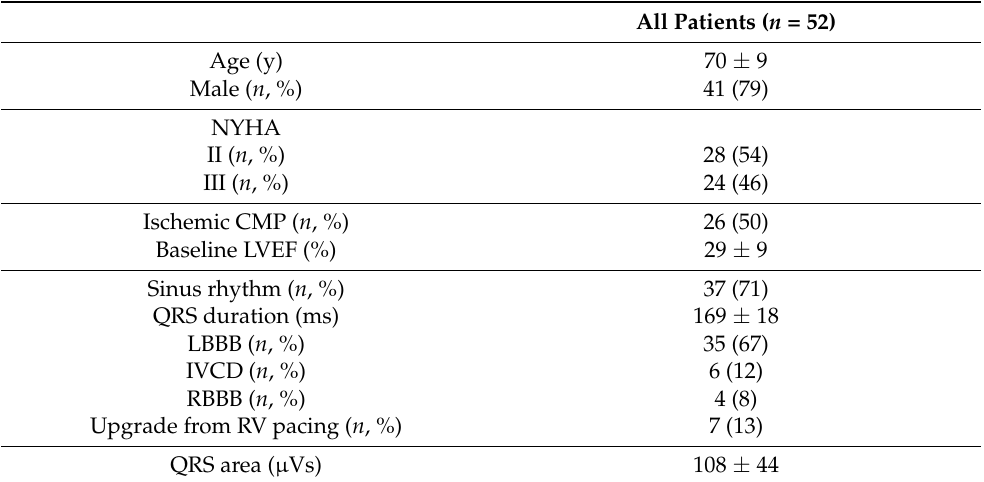
Table 1. Baseline characteristics of study